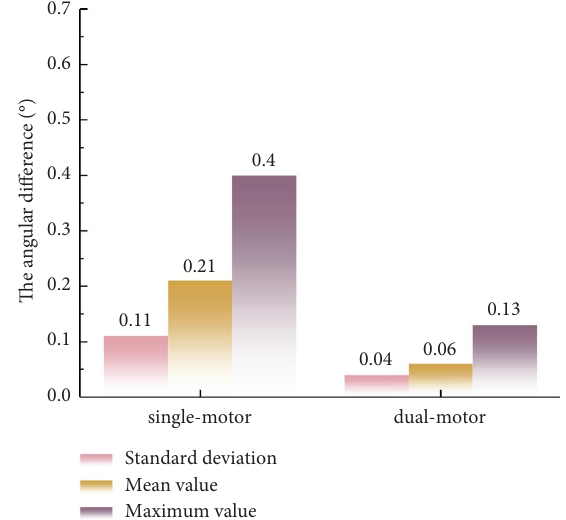
Figure 15: Te error caused by the